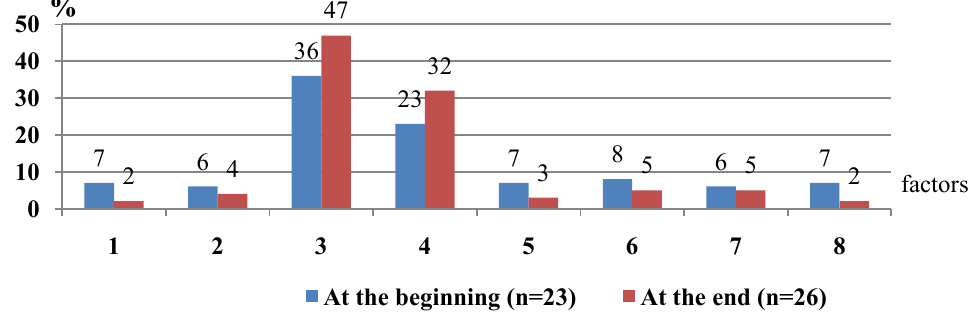
Fig.4. Factors of school anxiety of girls with slouchy posture during academic year: 1-8 see table 2.